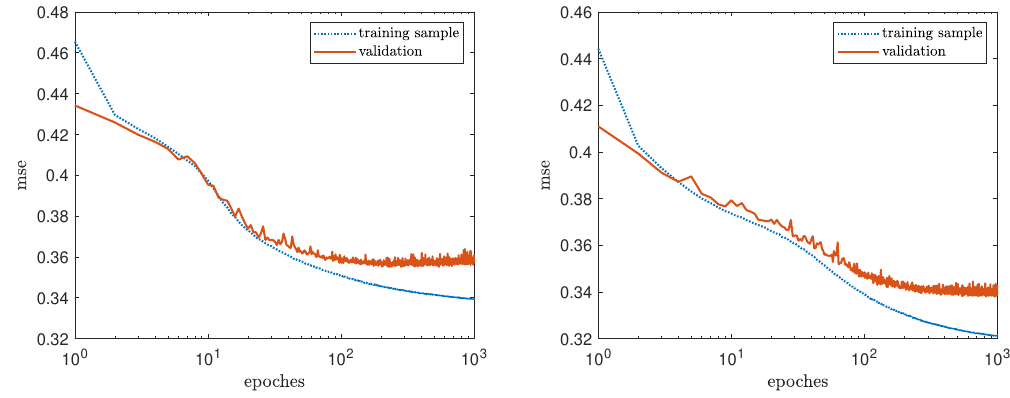
Figure 3 . The learning curves of the ANNs trained with V 0 , 2 data-sets.